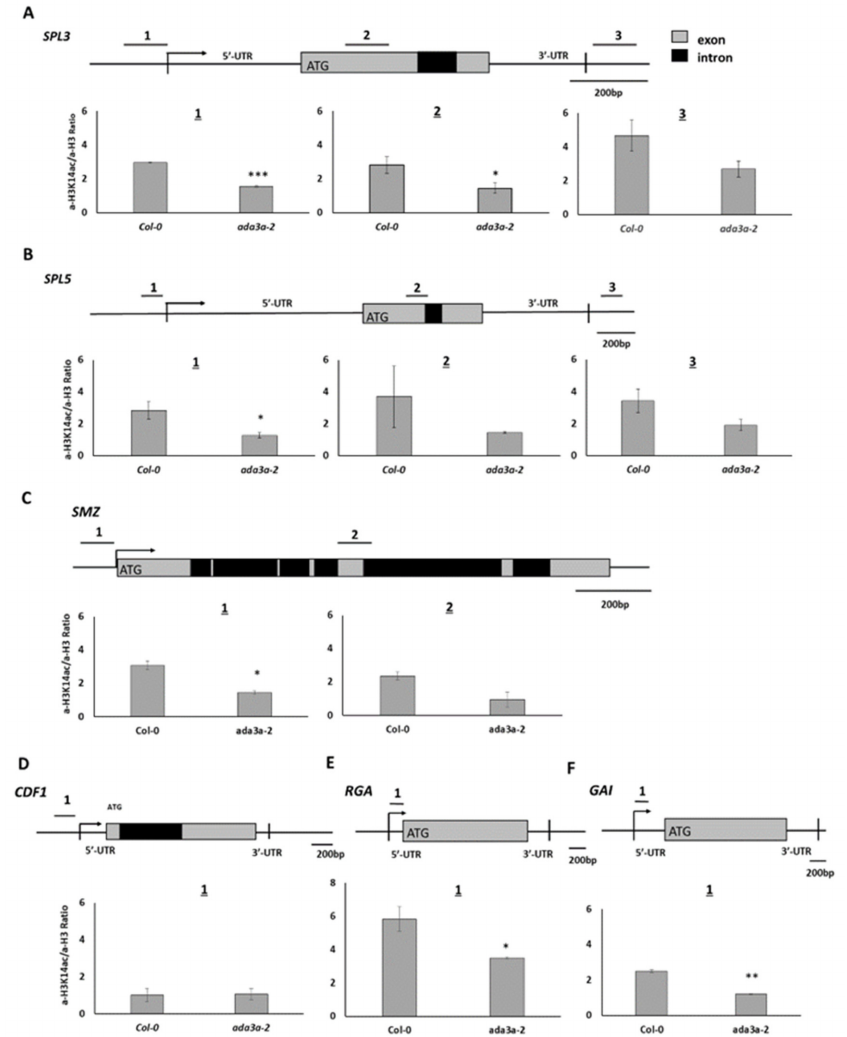
Figure 7. The acetylation status of H3K14 in the Arabidopsis thaliana Col-0 and ada3a-2 ten-days old plants. ( A ) Three genomic regions for the SPL3 and ( B ) SPL5 locus were analyzed: near the transcription start site (1), in the protein-coding region (2), and after the 3 (cid:48) untranslated region (3). ( C ) Two genomic regions were analyzed for the SMZ locus: one near the transcription start site (1), and one in the protein-coding region (2). ( D ) One genomic region was analyzed for the CDF1 locus, near the transcription start site, ( E , F ) for the RGA and GAI locus, within the 5 (cid:48) untranslated regions. Values were obtained by q-PCR as a percentage of input. Antibody for histone H3 was used as an internal control, and the ratio (percentage of input with H3K14ac/percentage of input with H3) is presented. The error bars represent standard error (SE) of three technical repeats. Statistical significance was calculated by t -test, * p < 0.05, ** p < 0.01, *** p <